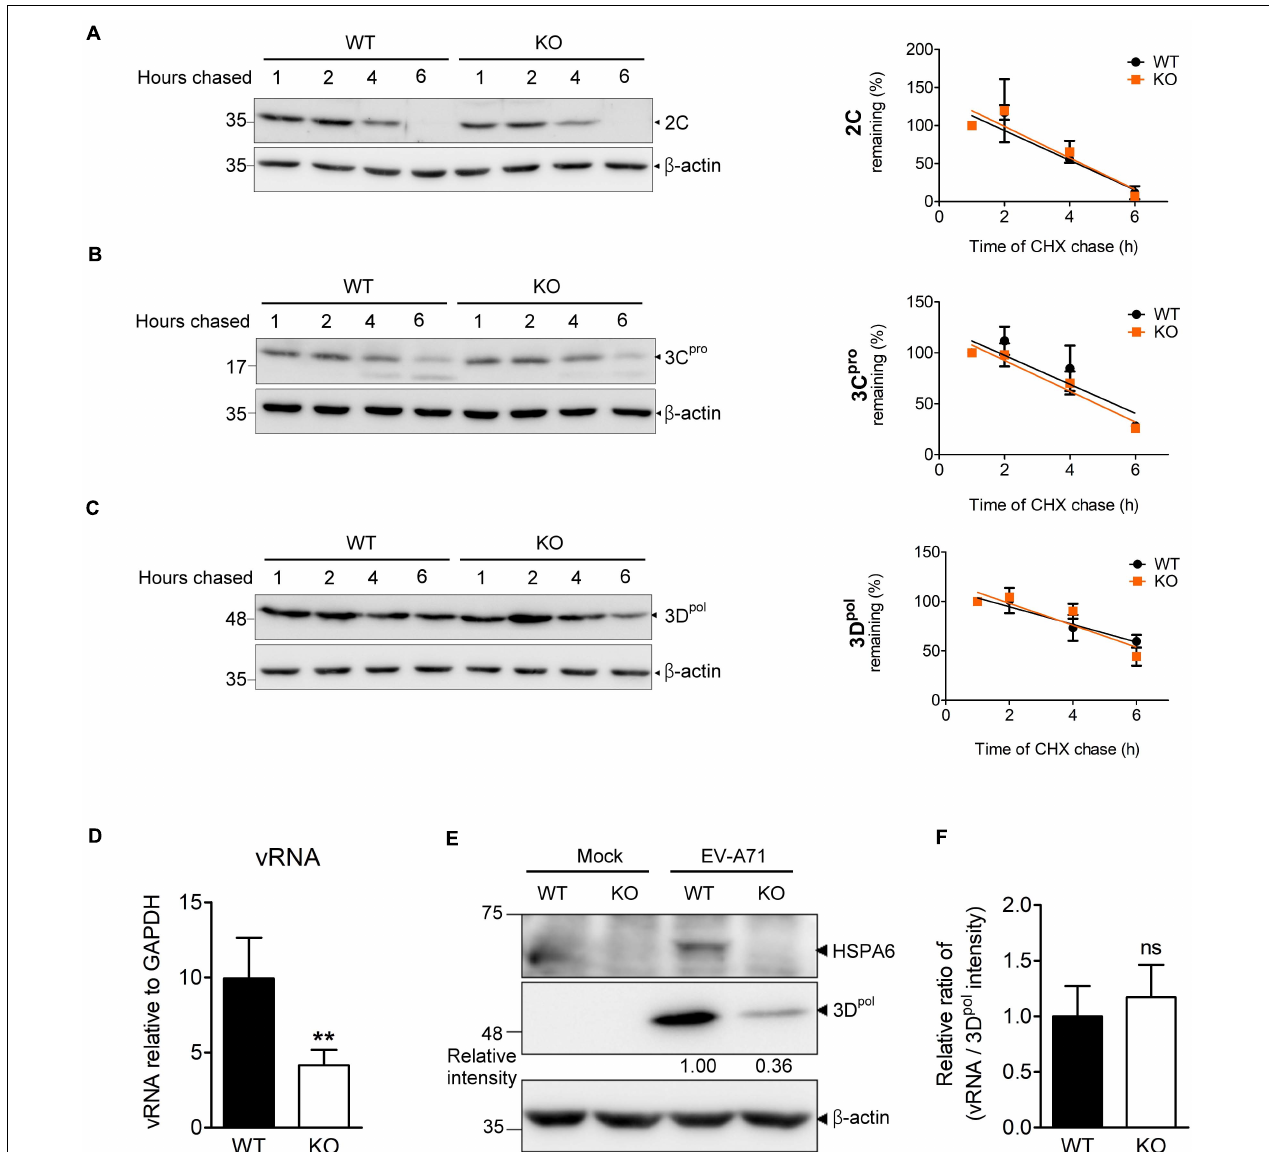
FIGURE 5 | HSPA6 depletion does not affect the protein stabilities of viral 2C, 3C pro , and 3D pol proteins, nor does it reduce EV-A71 replication efficiency. WT RD and HSPA6 KO RD cells were infected with EV-A71 (MOI = 5) and then treated with CHX (100 µ g/ml) at 9 hpi to stop translation. The remaining viral proteins (A) 2C, (B) 3C pro , and (C) 3D pol at 1, 2, 4, and 6 h after CHX treatment were examined by Western blot analysis (left panels). At each time point, the intensity for band specific to each protein from the Western analysis was quantified by ImageJ software. The value of each band was normalized with β -actin and plotted for the slope of linear regression curve. The band intensity from 1 h post CHX chase was arbitrarily set as 100% (right panels). (D–F) WT RD and HSPA6 KO RD cells were infected with EV-A71 (MOI = 5) and harvested for the analyses of (D) cell-associated vRNA and (E) viral protein 3D pol at 6 hpi. (F) A normalization of cell-associated vRNA with viral polymerase 3D pol expression (vRNA/3D pol ) was calculated to represent the replication efficiency in WT RD and HSPA6 KO RD cells. The data were presented as means ± SD ( n = 3) and analyzed by unpaired Student’s t -test. ns, not